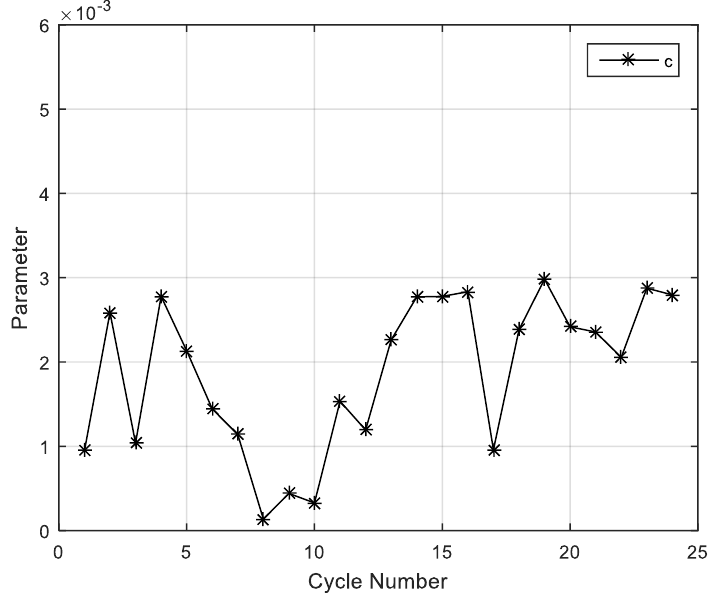
Figure 4. Variation of the ML estimate of the parameter 𝑐 over different sunspot